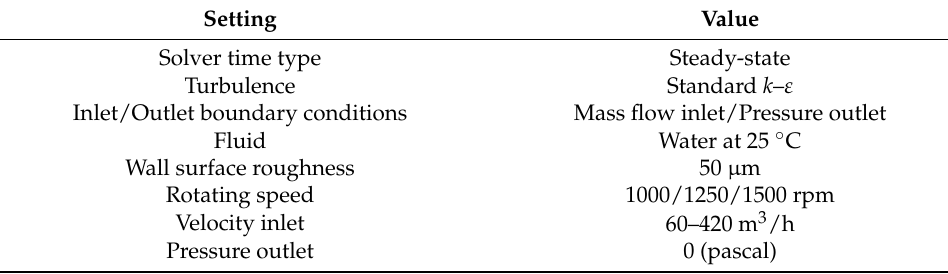
Table 2. Boundary conditions setting in FLUENT